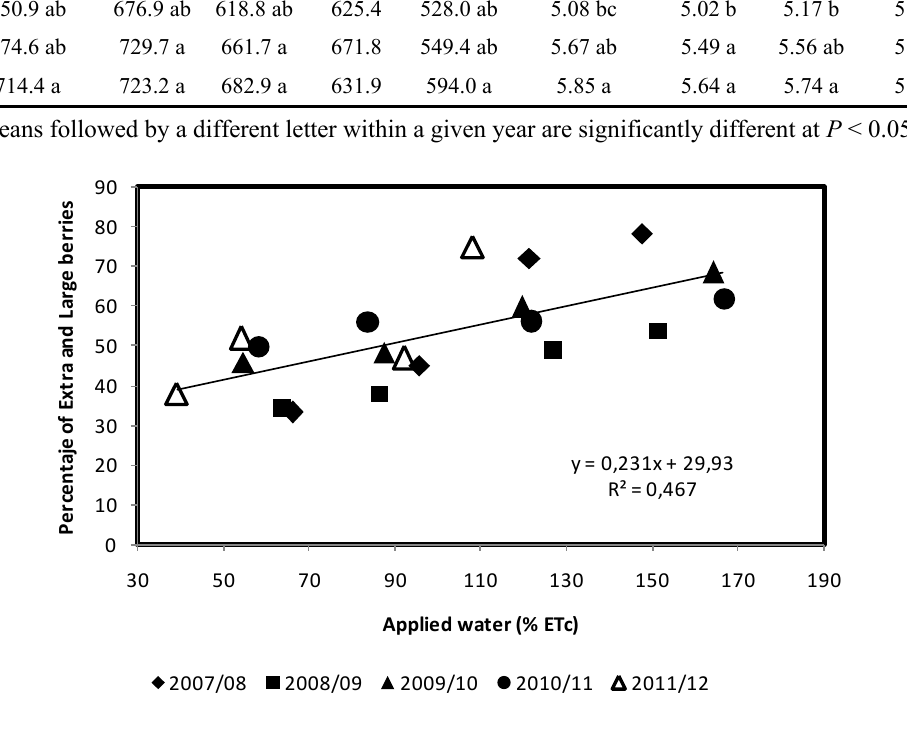
Figure 3. Relationship between percentage of Extra and Large berries and percentage ETc of water applied in the different experimental